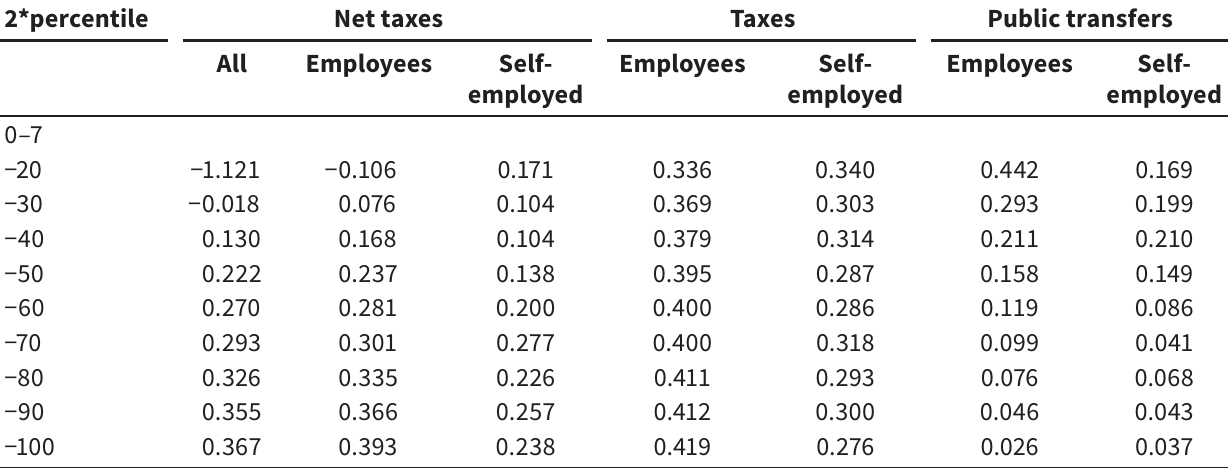
Household statutory average net tax rates in Lithuania, net taxes as a share of gross employment income